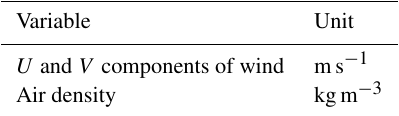
Table 5. COSMO-CLM upper-air parameters (with units) at 10 heights (20, 40, ... ,200m) archived by ICHEC at 1h intervals.